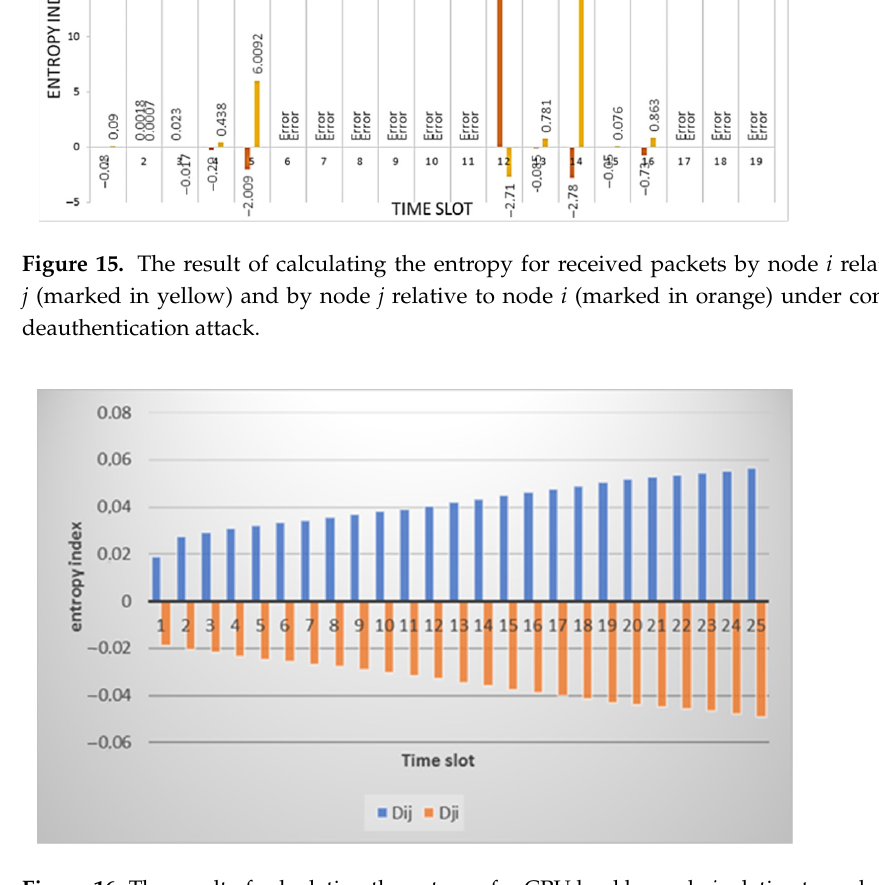
Figure 16. The result of calculating the entropy for CPU load by node i relative to node j (marked in blue) and by node j relative to node i (marked in orange) by the impact of a deauthentication attack.